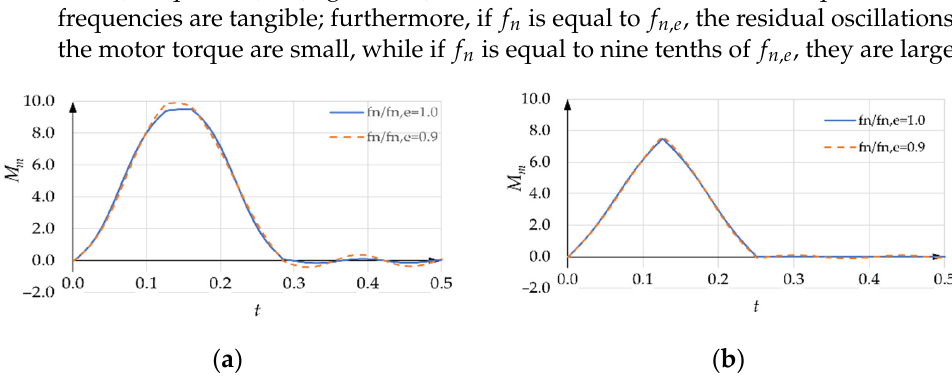
Figure 22. Load velocity versus time: ( a )